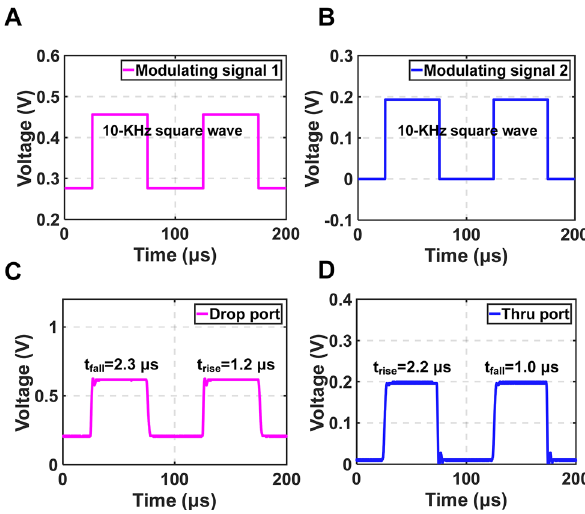
Figure 8: Temporal responses of the switch. (A) The square-wave driving signal loaded onto the heater of PCN1. (B) The square-wave driving signal loaded onto the heater of PCN2. (C) The output signal from the drop port. (D) The output signal from the through port of the switch.